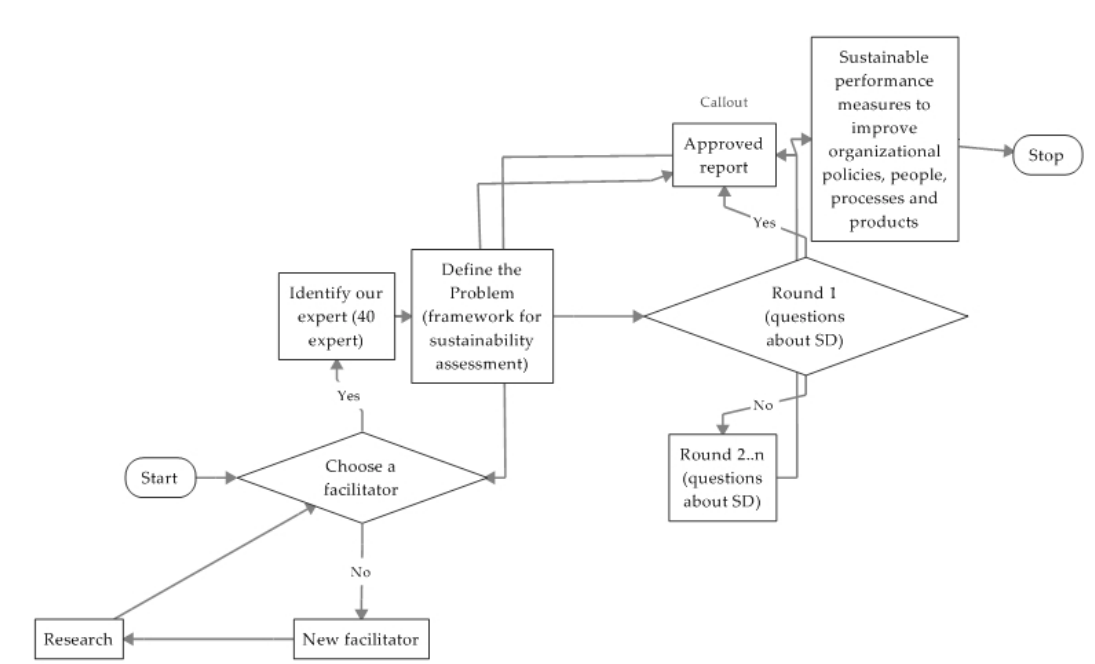
Figure 1. The stages of the Delphi method used in establishing the hierarchical framework for sustainability assessment of manufacturing industry. Table 2. Sustainable development and Industry